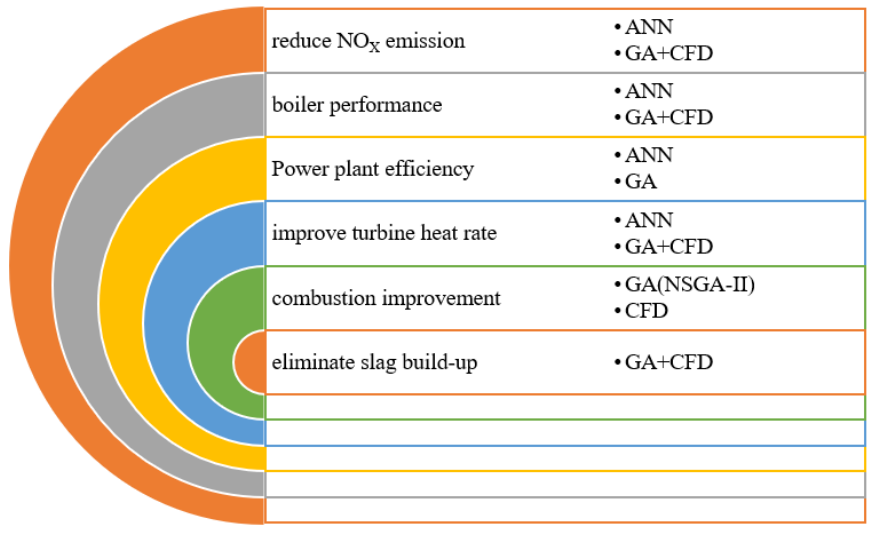
Figure 2. Optimizing tools to improve the performance of the process [14 –